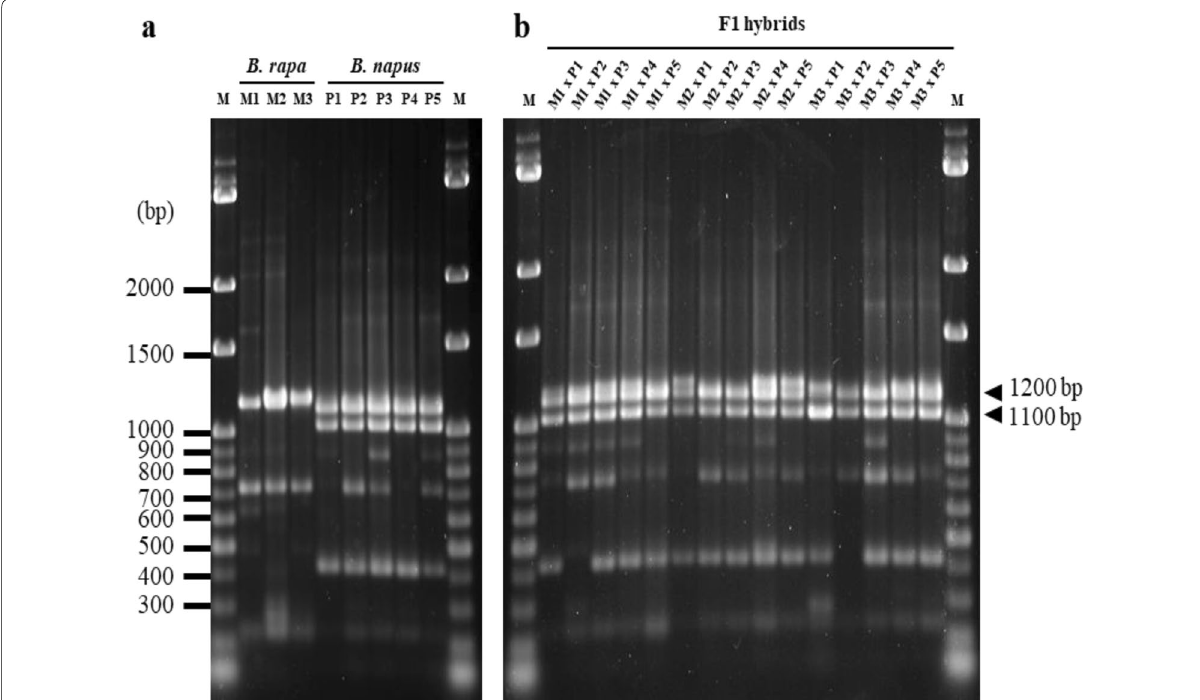
Fig. 3 SRAP marker analysis using the me5‑em1 primer set. Banding patterns for B. rapa and B. napus parents ( a ) and the F 1 hybrids ( b ) were separated by 1.8% agarose gel. M: 100 bp marker. M1: “Nongxing 80 days,” M2: “Wansheng rape,” M3: “Edible rape,” P1: “Deza oil No. 18,” P2: “Gueiza No. 4,” P3: “Zhong oil No. 36,” P4: “Wan oil No. 25,” and P5: “FTHEB 1001.” White arrows indicate specific fragments (1.1 kb and 1.2 kb) in B. napus and crossed